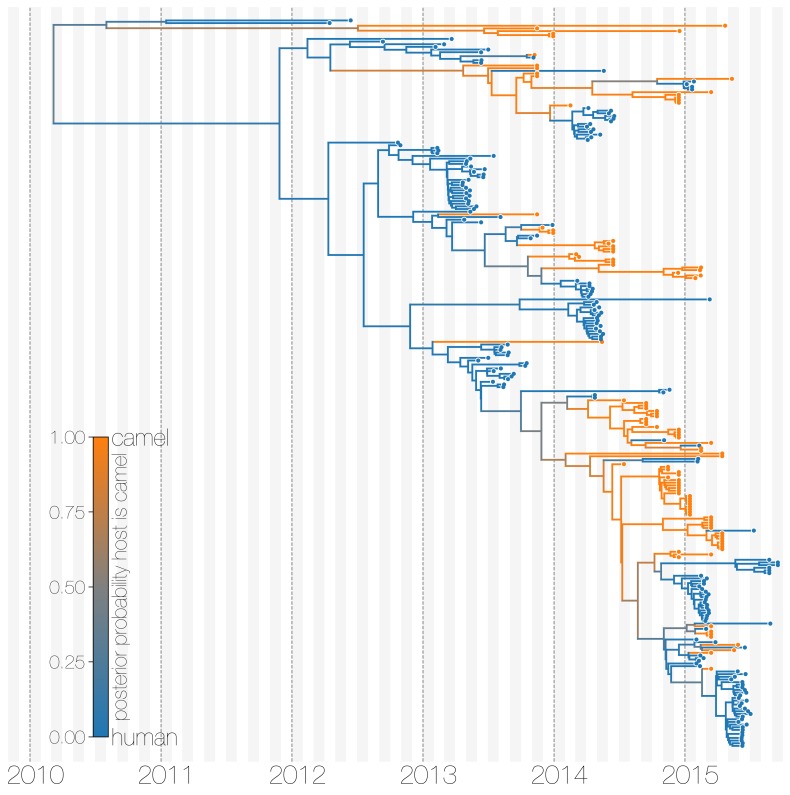
Maximum clade credibility (MCC) tree with ancestral state reconstruction according to a discrete trait model.MCC tree is presented the same as Figure 1 and Figure 1—figure supplement 4, with colours indicating the most probable state reconstruction at internal nodes. Unlike the structured coalescent summary shown in Figure 1 where camels are reconstructed as the main host where MERS-CoV persists, the discrete trait approach identifies both camels and humans as major hosts with humans being the source of MERS-CoV infection in camels.